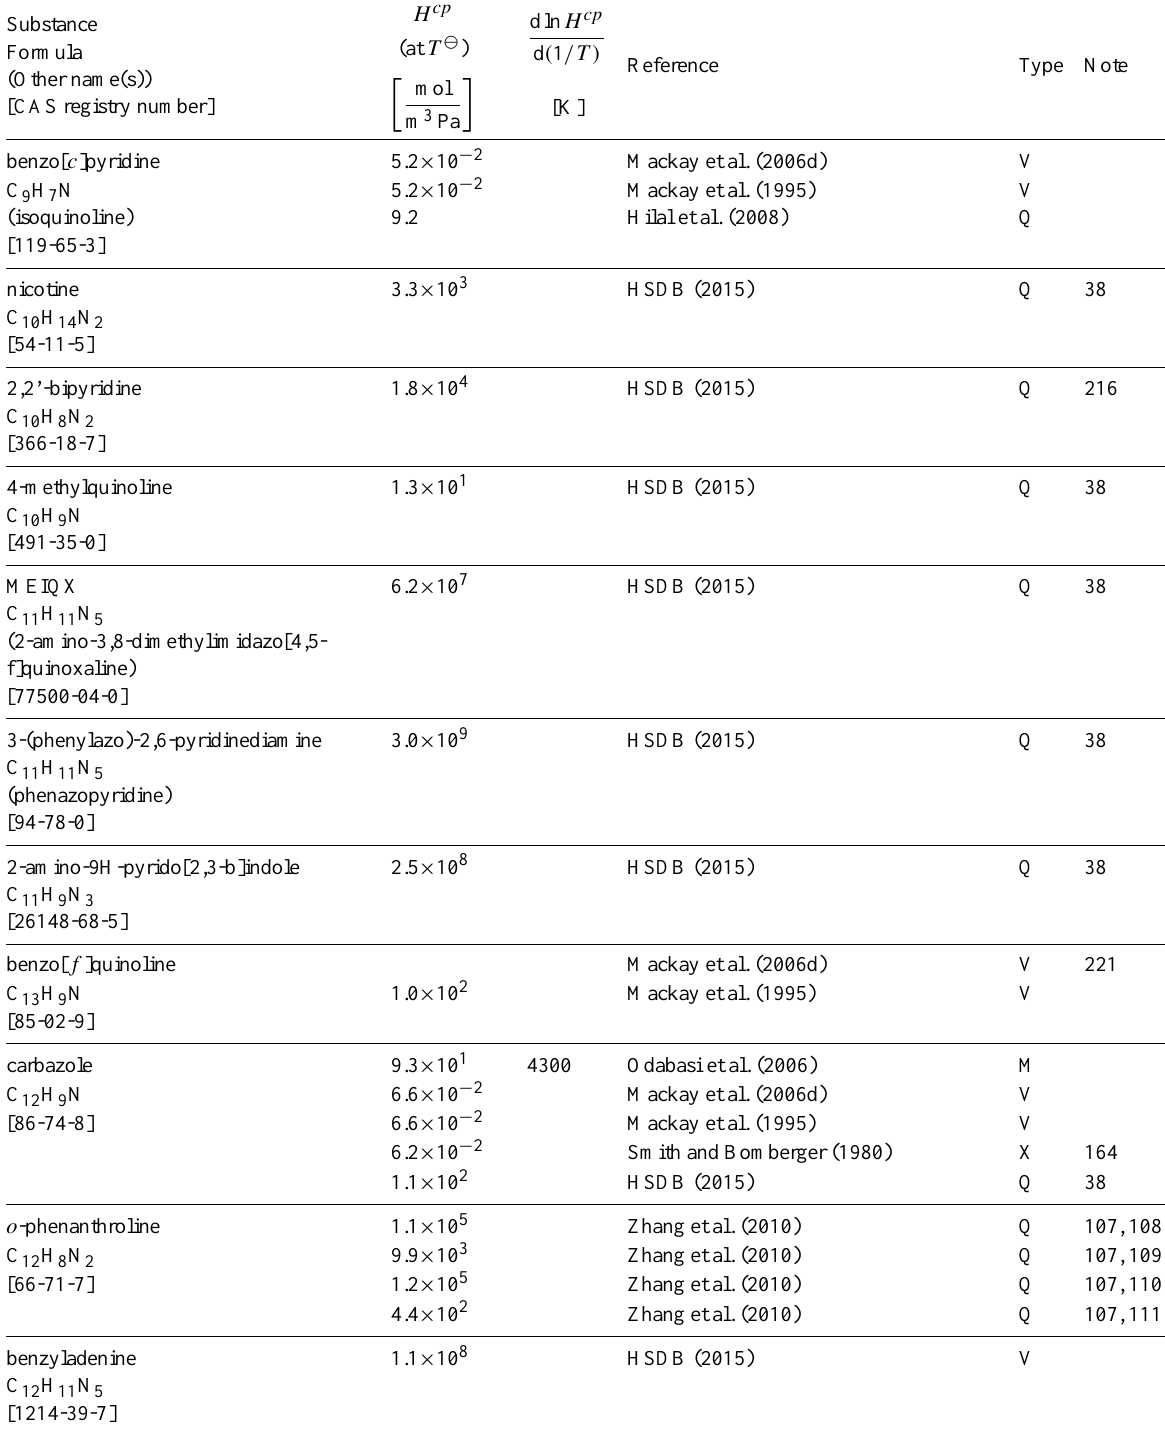
Table 6: Henry’s law constants for water as solvent